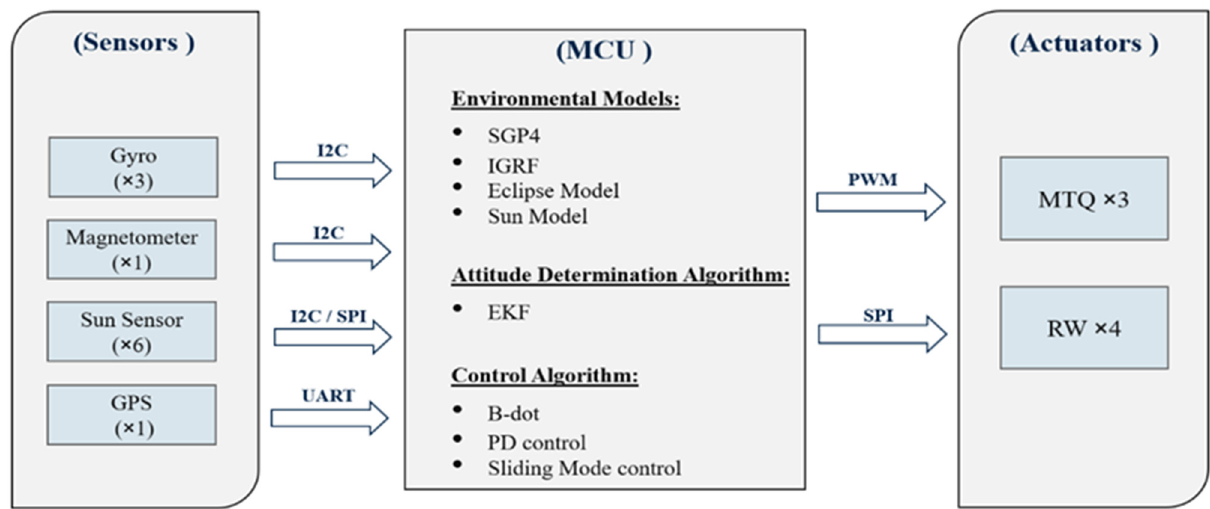
Figure 7. Light-1 ADCS breakdown.